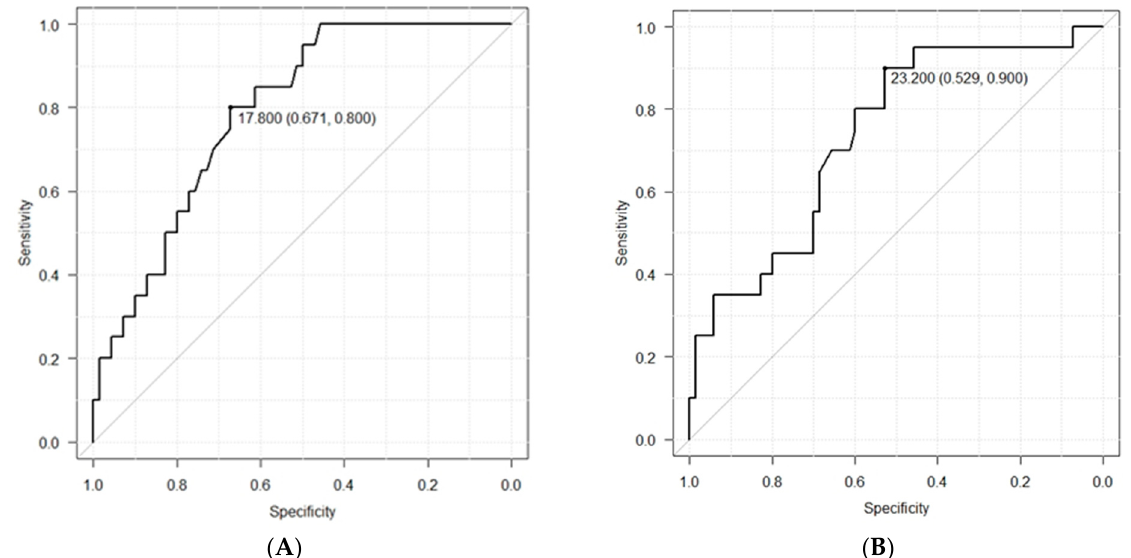
Figure 4. Receiver operating characteristic (ROC) curve analysis 6 and 24 h after extubation. ( A ) ROC curve analysis 6 h after extubation. ( B ) ROC curve analysis 24 h after extubation. It is possible to estimate diagnostic cutoff values from ROC curves.